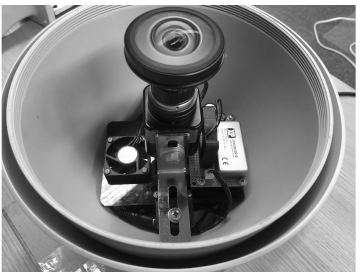
Figure 4: Inside of the housing dome. The housing dome consists of a CCD camera with fisheye lens, DCDC con- verter and two